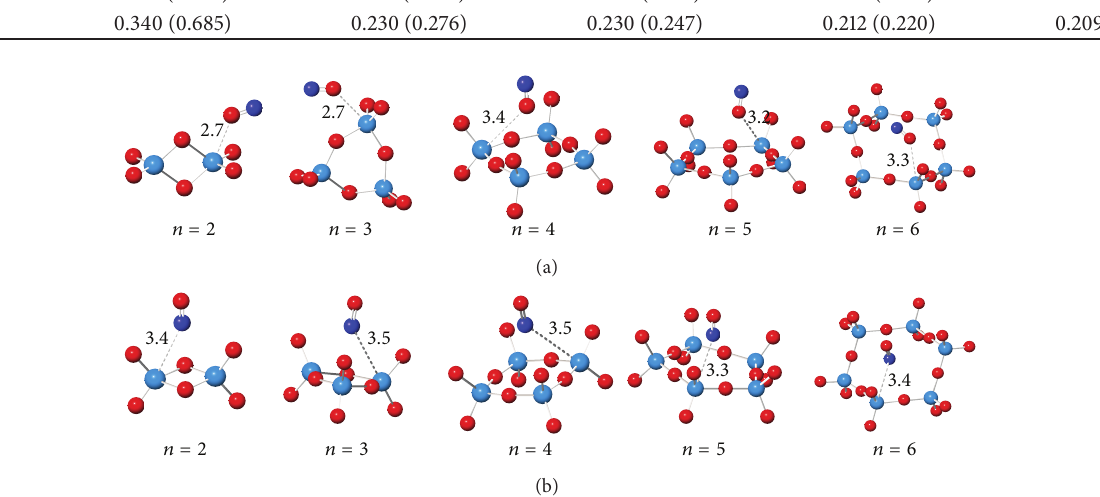
Figure 2: Optimized structures of NO adsorption on the ( WO 3 ) 𝑛 clusters at X3LYP functional: (a) through the O-head and (b) through the N-head of NO molecule.